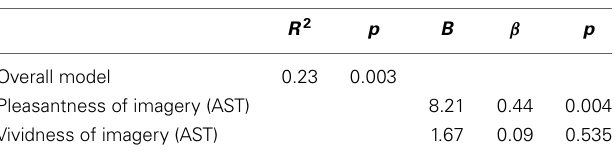
Table 2 | Positive interpretation bias predicts resilience cross-sectionally.